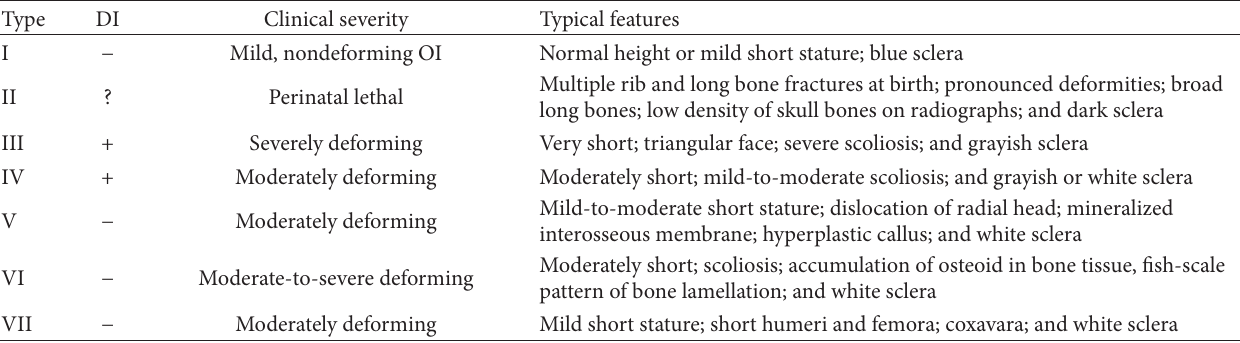
Table 1: Classification of osteogenesis imperfecta.